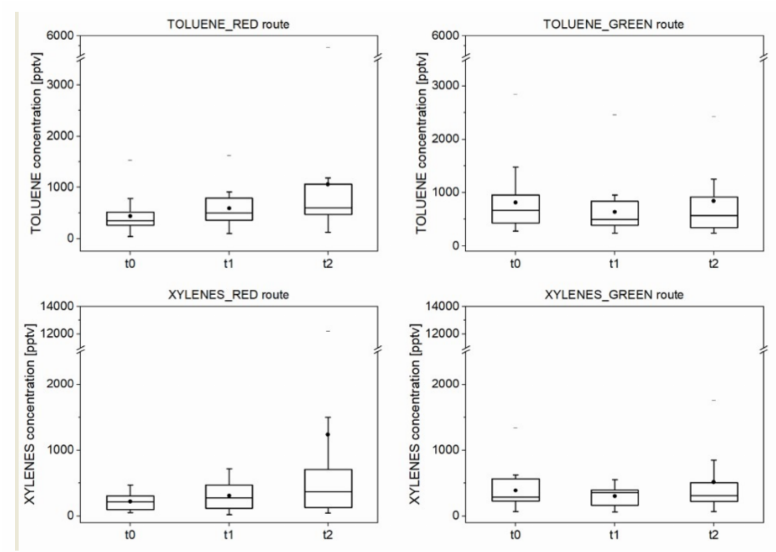
Figure 5. Box-plot of the concentration (expressed in pptv) of the traffic-related VOCs measured in the breath samples ( n = 15 subjects) collected at the established times before the walk (t0), at its end (t1), and after the run (t2), during the tests on both green and red routes. Note: The box-plot shows the minimum, the 5th and the 25th percentiles, the median, the 75th and 95th percentiles, and the maximum values for each variable investigated. The dot inside the box shows the mean